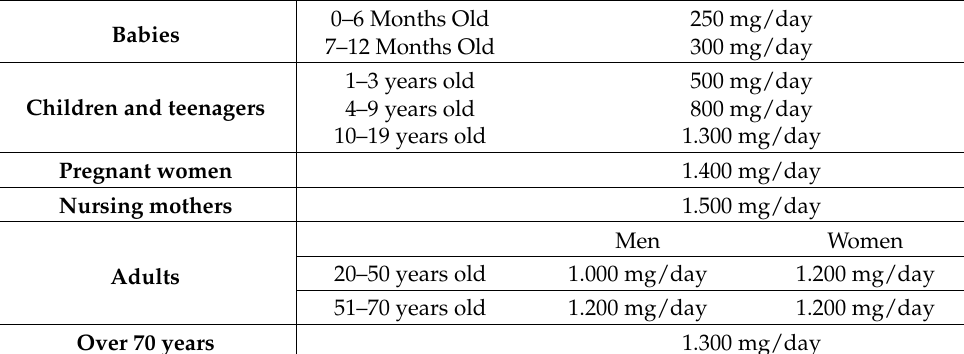
Table 3. Daily needs of calcium by age groups (from ref.